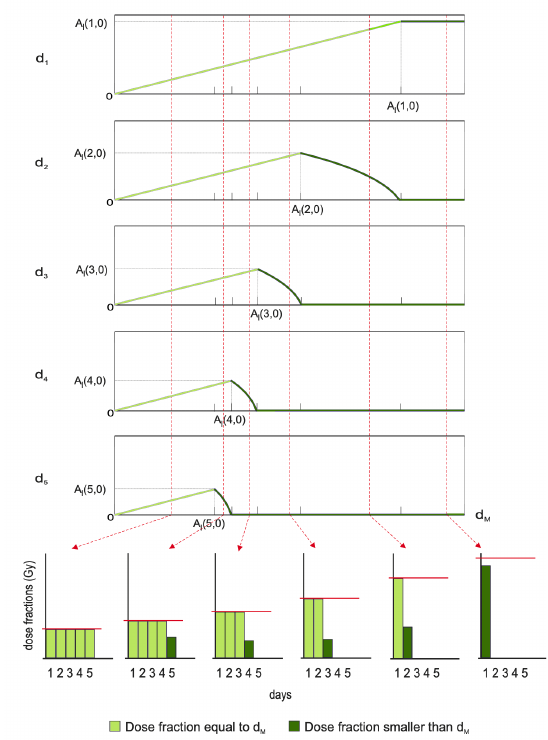
Figure 2. Optimal fractions d i , i = 1, . . . ,5, for prevalent late constraint and ρ < ρ l (see Table 7): ( Top ) patterns of the dose fractions as functions of d M ; and ( Bottom ) optimal weekly schedules (vertical bars) corresponding to significant values of d M (limiting horizontal